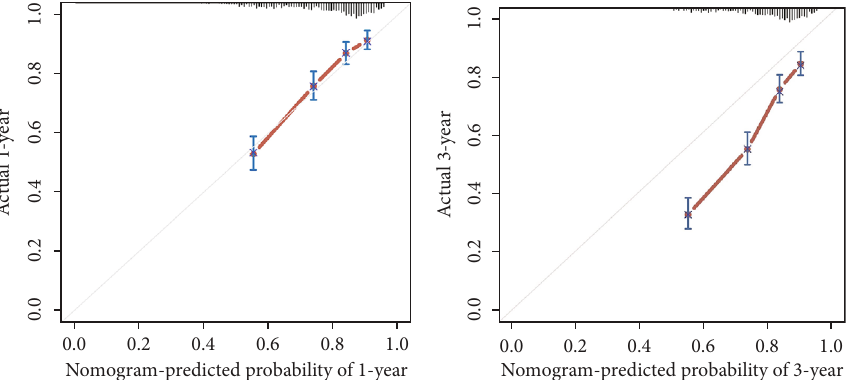
Figure 4: The calibration curves in the internal validation cohort.